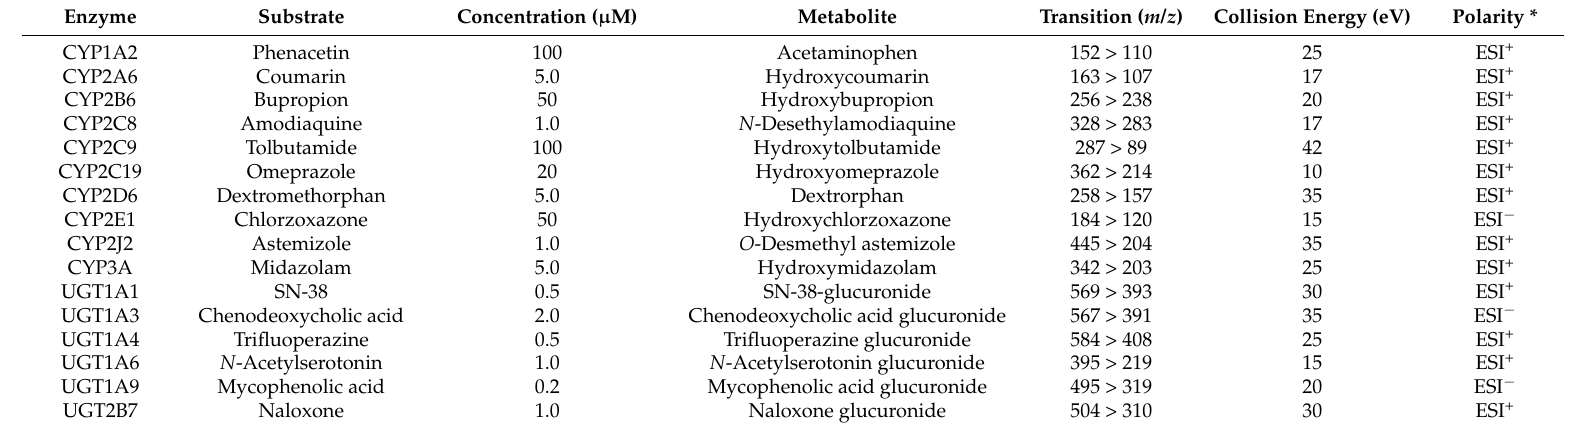
Table 2. Selected reaction monitoring (SRM) parameters for the metabolites of ten cytochrome P450 and six uridine 5 (cid:48) -diphosphoglucuronosyltransferase probe substrates. Enzyme